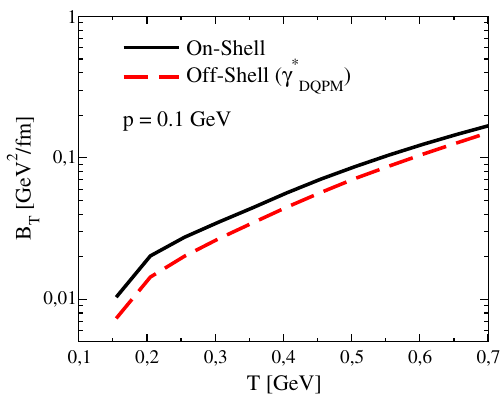
Fig. 3 Diffusion coefficient B T ( T ) as a function of the medium tem- perature at fixed HQ momentum p = 0 . 1 GeV for on-shell approach (black solid line) and off-shell approach (red dashed line)